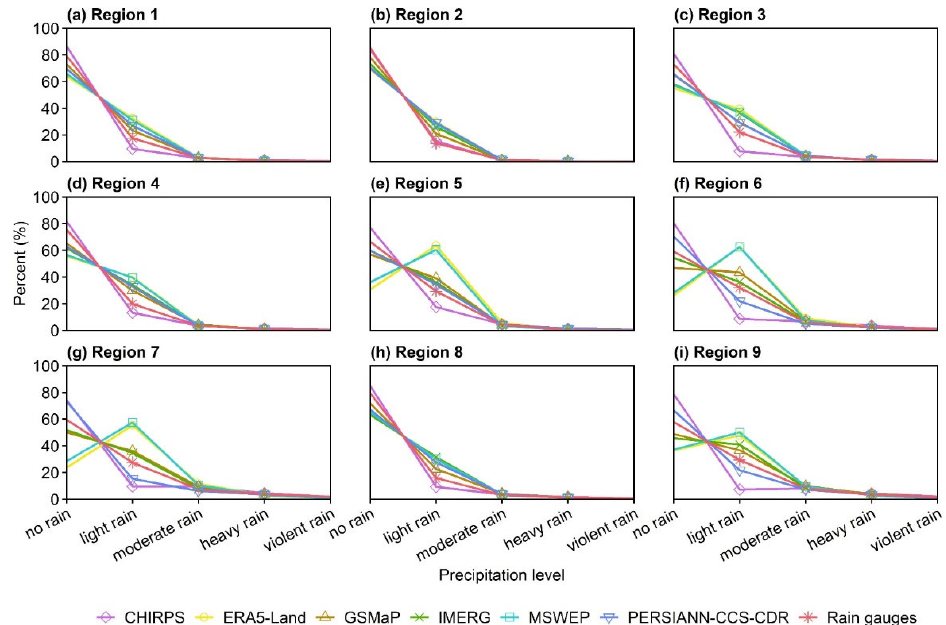
Figure 6. Probability density function of the daily precipitation rate of rain gauges and six precipi ‐ tation products in different regions ( a–i ) between 2015 and